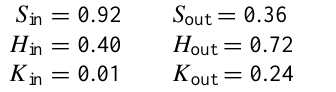
Fig. 7. Energy outflow in a particle-in-cell simulations of magnetic reconnection, showing (a) Poynting flux S z , (b) ion enthalpy flux H iz , and (c) electron enthalpy flux H ez , and (d) bulk kinetic energy flux K z . The red rectangles indicate the boundaries of a box used to integrate incoming and outgoing energy fluxes discussed in the text.